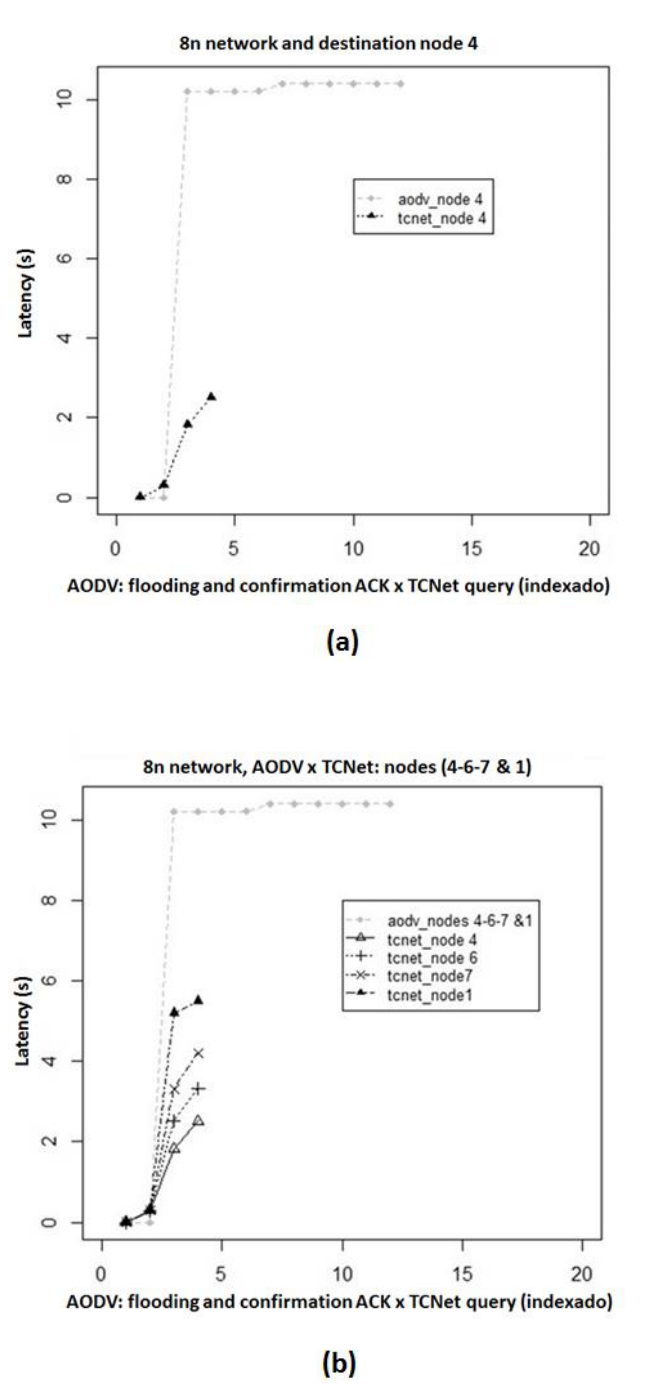
Figure 8 . (a) Comparison of 1 TCNet query and AODV signaling mechanism to establish a route to node 4; (b) Scenario of comparing TCNet queries for an 8-node network with respect to AODV.